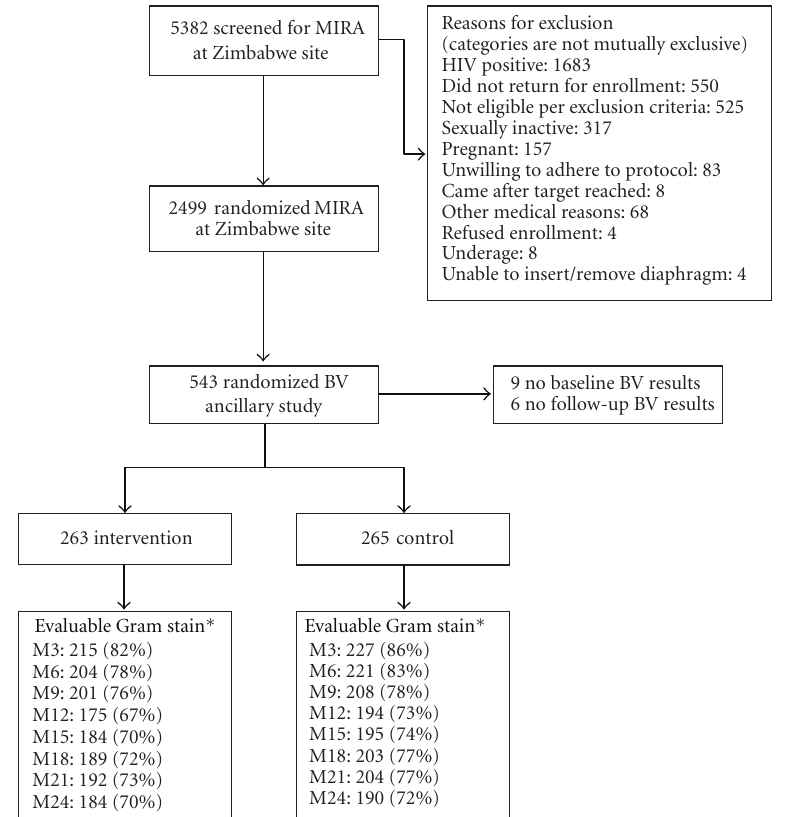
Figure 1: Bacterial vaginosis (BV) ancillary study trial profile: ∗ number with an evaluable vaginal Gram stain at each follow-up visit by arm and percent evaluable over total number enrolled in each arm (number evaluable is less than those presenting for followup mainly due to menses a time when specimens for vaginal Gram stain were not obtained) † M: month of follow-up